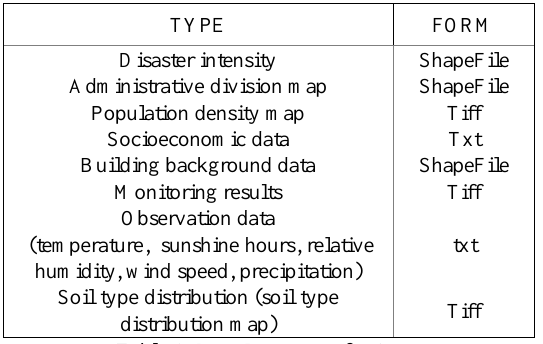
Table 1. Data Resources for